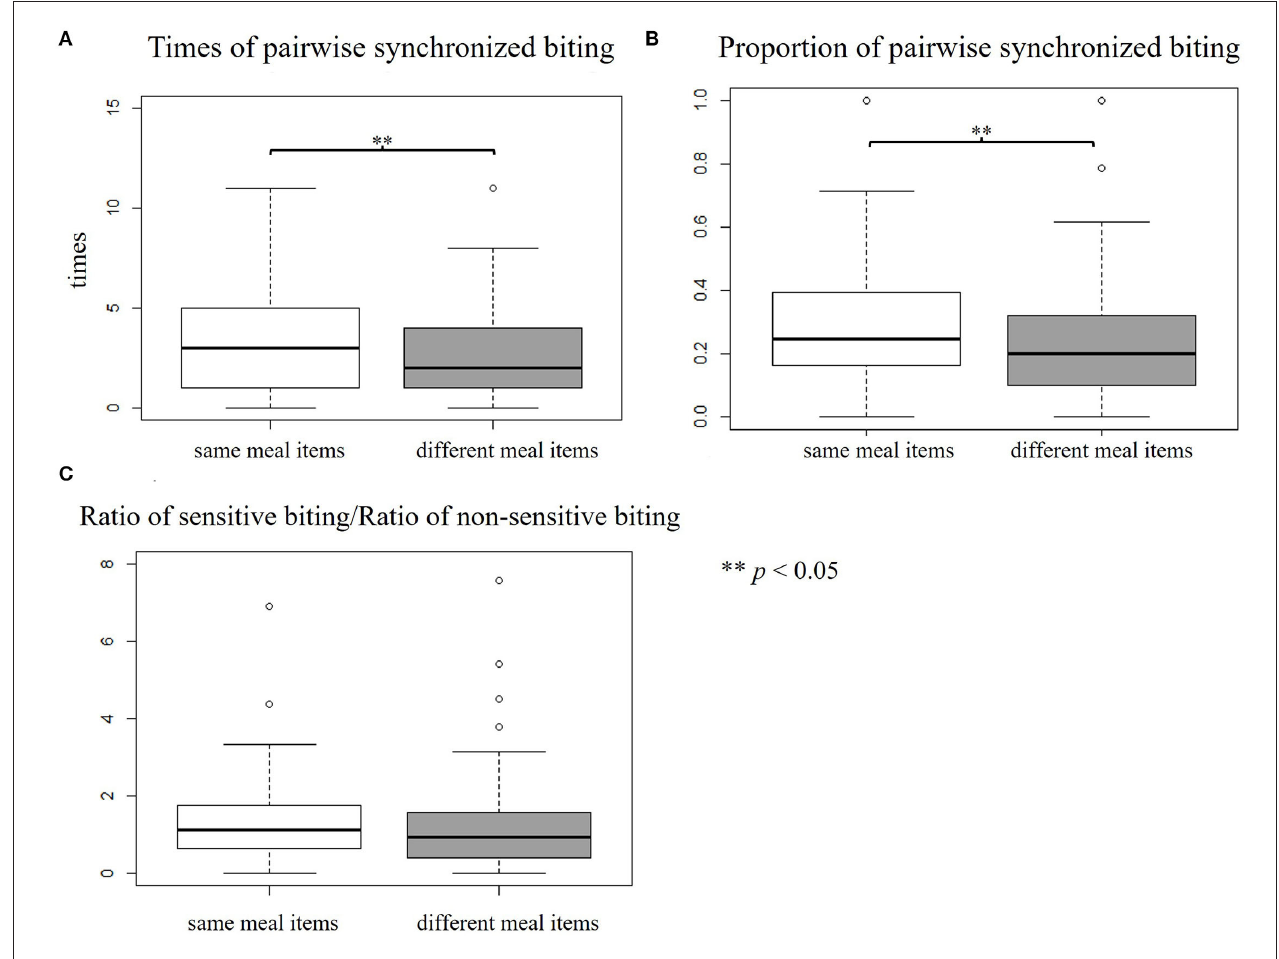
FIGURE 5 | Numbers of (A) pairwise synchronized bites over 5min. Proportions of (B) pairwise synchronized biting and (C) likelihood of biting